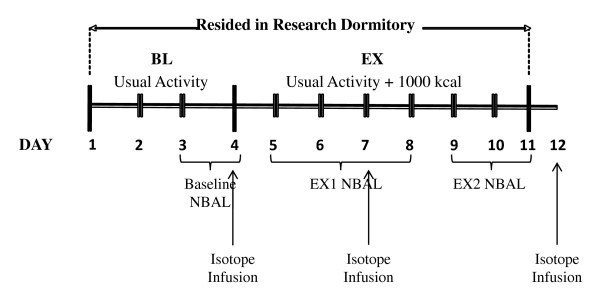
Experimental Design.